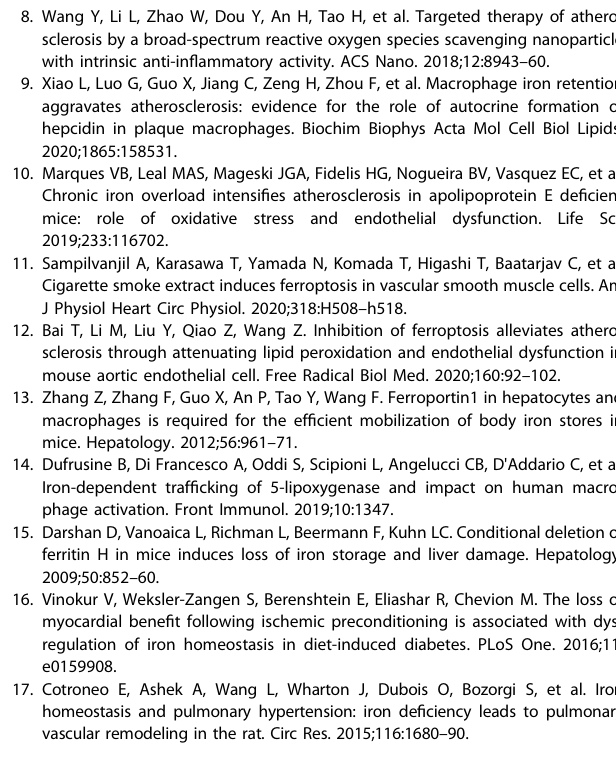
Fig. 2 Role of ferroptosis mutual effect of AS in endothelial cells. The accumulation of lipid peroxides in endothelial cells that cause ferroptosis derived from two pathways. The extracellular ox-LDL causes endothelial cell mitochondrial damage, and intracellular iron overload causes lipid peroxide accumulation, which can be reserved by fer-1. Meanwhile, ATF3 inhibits its clearance pathway, and has a protective effect on atherosclerosis by reducing the damage of elastic membrane by inhibiting the PI3K-MMP3 pathway. The ferroptosis of endothelial cell and elastic lamina damage leads to endothelial dysfunction promoting the formation of